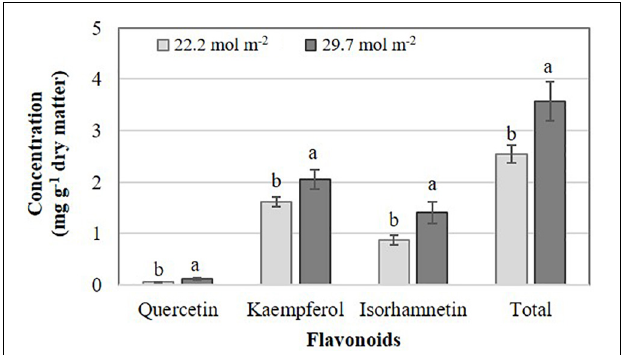
FIGURE 2 | Effects of mean daily photosynthetically active radiation (PAR) on flavonoid concentration in B. campestris cv. Mibuna Early. Means ± SD with different letters in each variable analyzed indicate significant differences at P ≤ 0.05 (Tukey’s